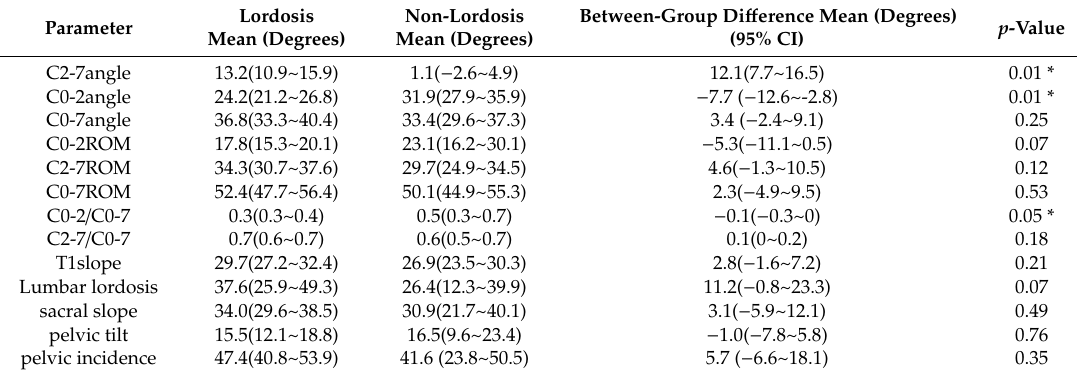
Table 3. Comparison of pre-operative radiographic parameters between lordosis and non-lordosis. Parameter.